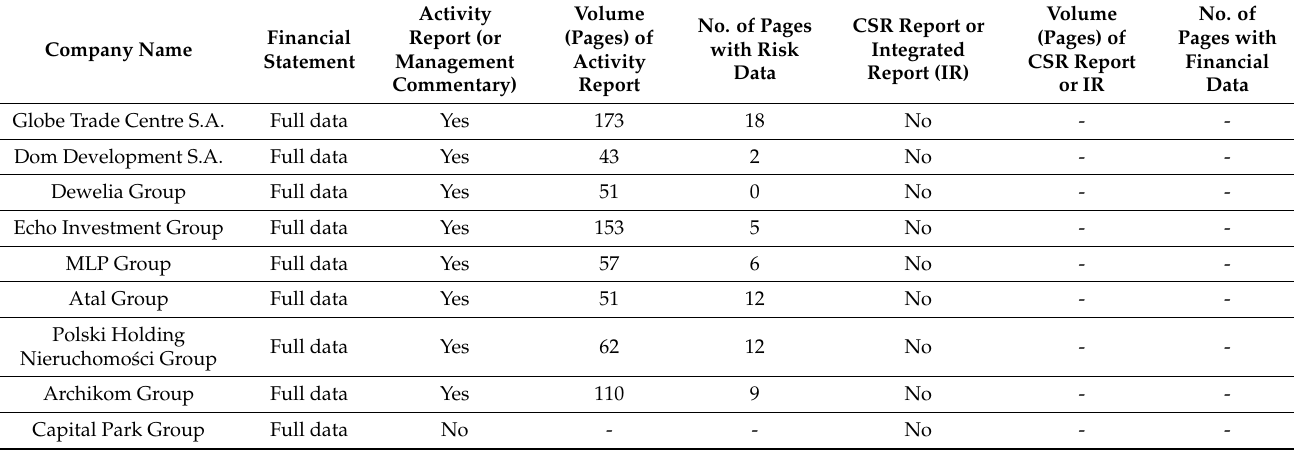
Table 2. Overview of analysed annual statements, CSR, and integrated reports of GPW listed companies operating in the construction and property development industry